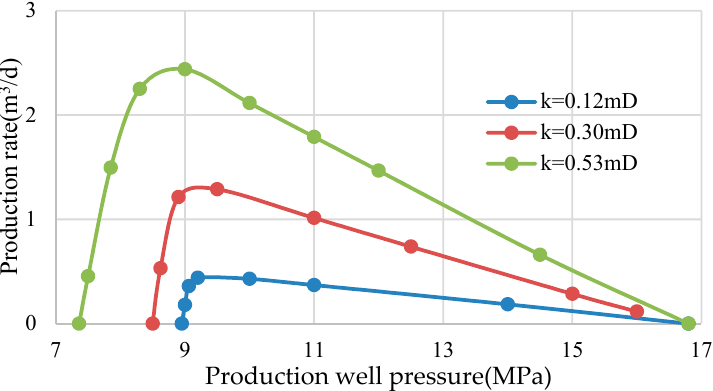
Figure 14. The relationship between the production rate and the production well pressure before